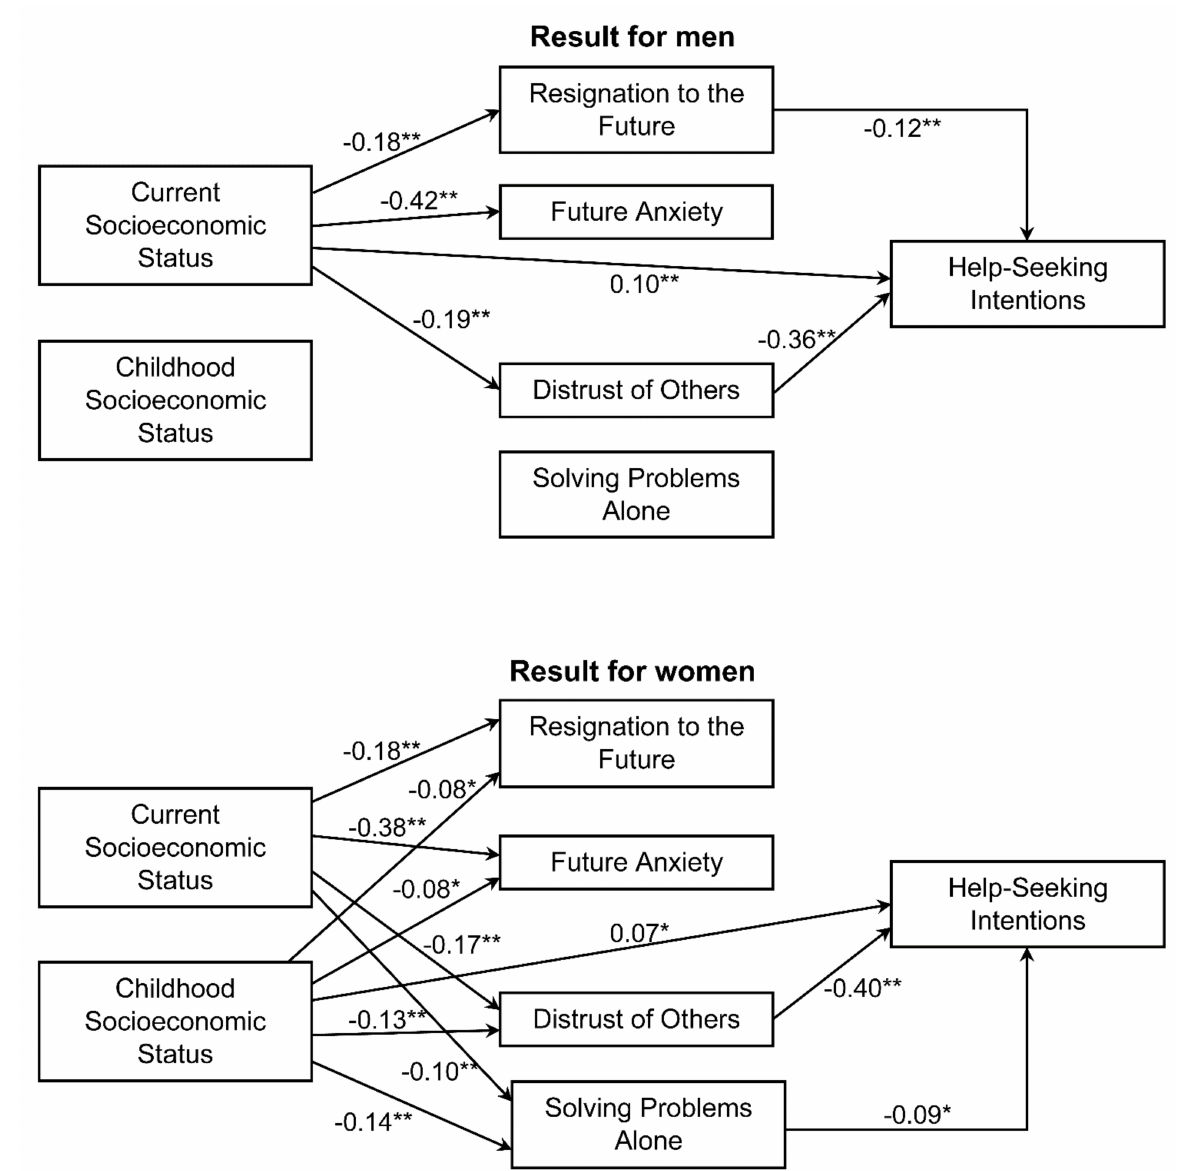
Figure 2. Multigroup structural equation modeling results for men and women. All values are standardized estimates. Age, error terms, and covariance have been omitted. Only paths significant at the 5% level are shown. (* p < 0.05, ** p <